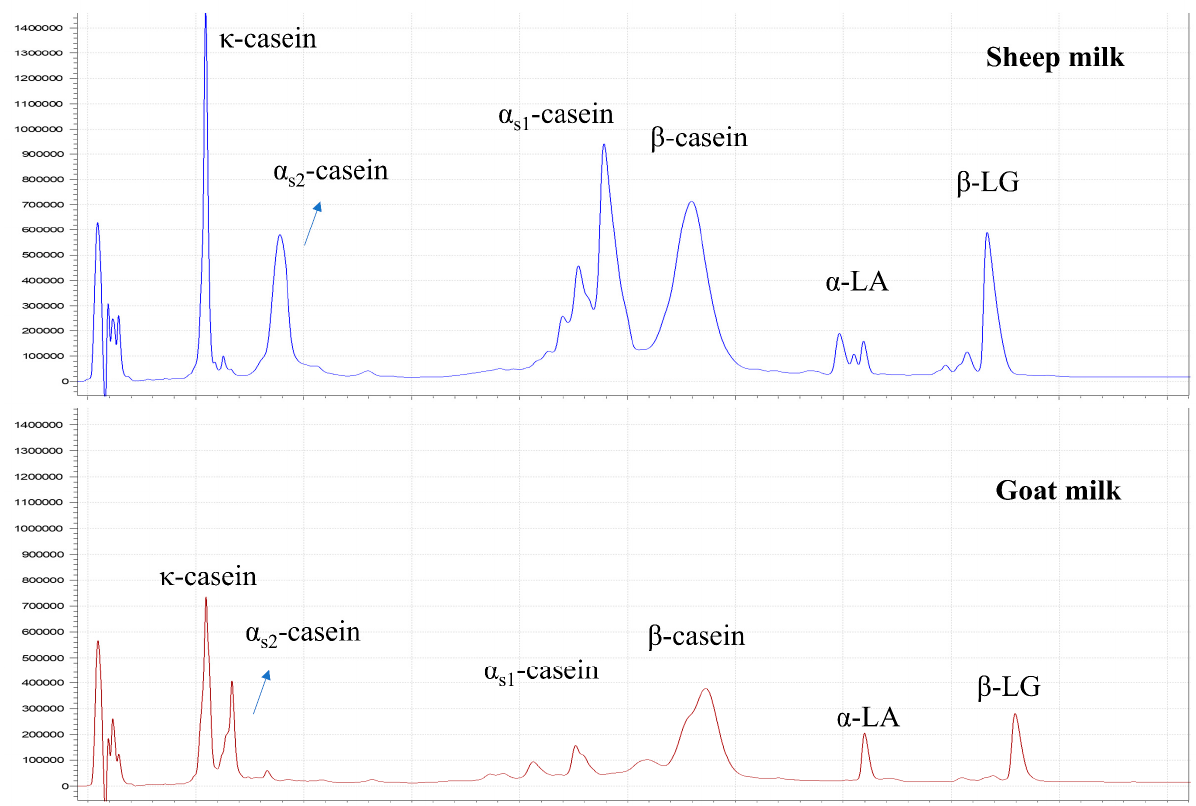
Figure 1. High-performance liquid chromatography profiles of proteins in sheep milk and goat milk.